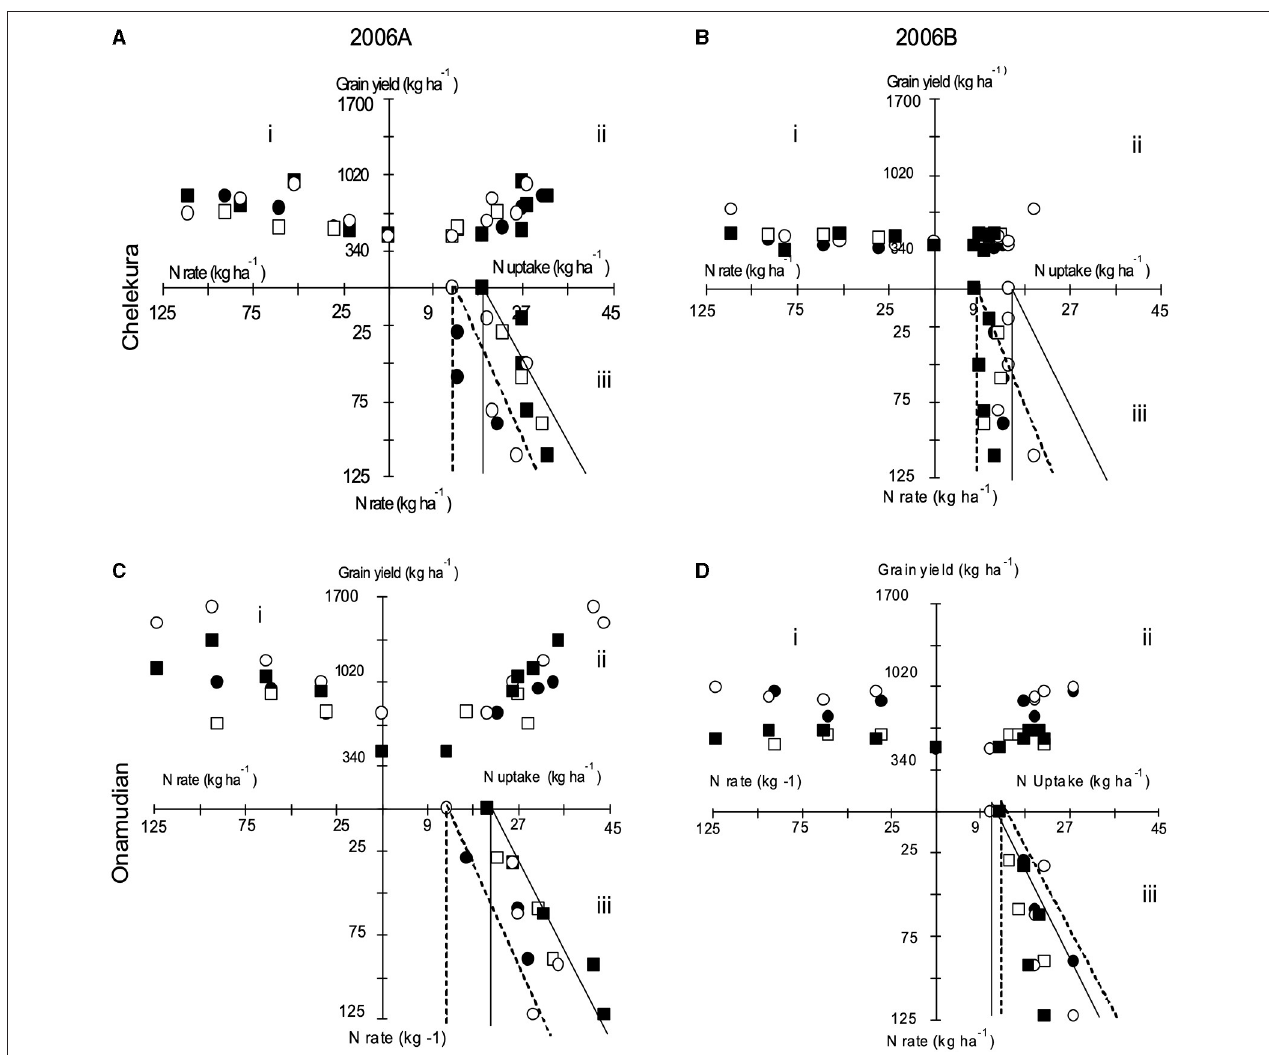
FIGURE 2 | Three-quadrant diagrams showing relationships between N application, N uptake, and grain yield of finger millet. (i) Yield against fertilizer rate (fertilizer use efficiency), (ii) yield against N uptake (physiological N use efficiency), (iii) N uptake against fertilizer application rate (fertilizer recovery) in degraded fields located on the upper and middle landscape positions in Chelekura (A,B) and Onamudian (C,D) village during seasons 2006A (A,C) and 2006B (B,D) . Open square, N alone, upper landscape position; full square, manure (3t ha − 1 ) + N, upper landscape position; (full circle), nitrogen alone, middle landscape position; open circle, manure (3t ha − 1 ) + N, middle landscape position. Areas under bold line and dotted lines respectively represent ANR under 25% in the upper and middle landscape positions,